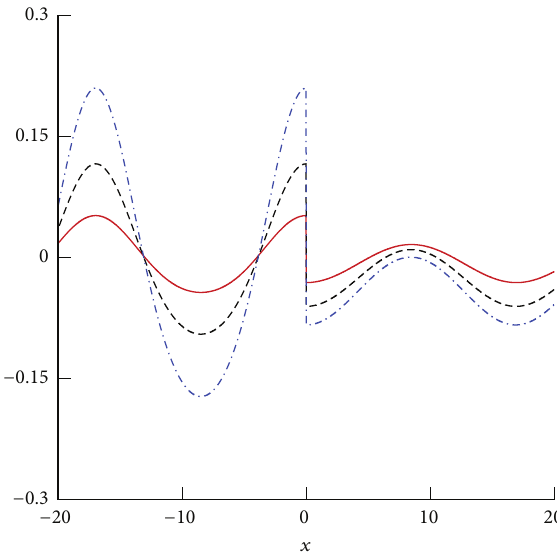
Figure 6: Variation of incident progressive waves and hydroelastic deflection of the plate versus 𝑥 for different plate thicknesses 𝑑 . Solid line: 𝑑 = 0.003 m; dashed line: 𝑑 = 0.01 m; dash-dotted line: 𝑑 = 0.015